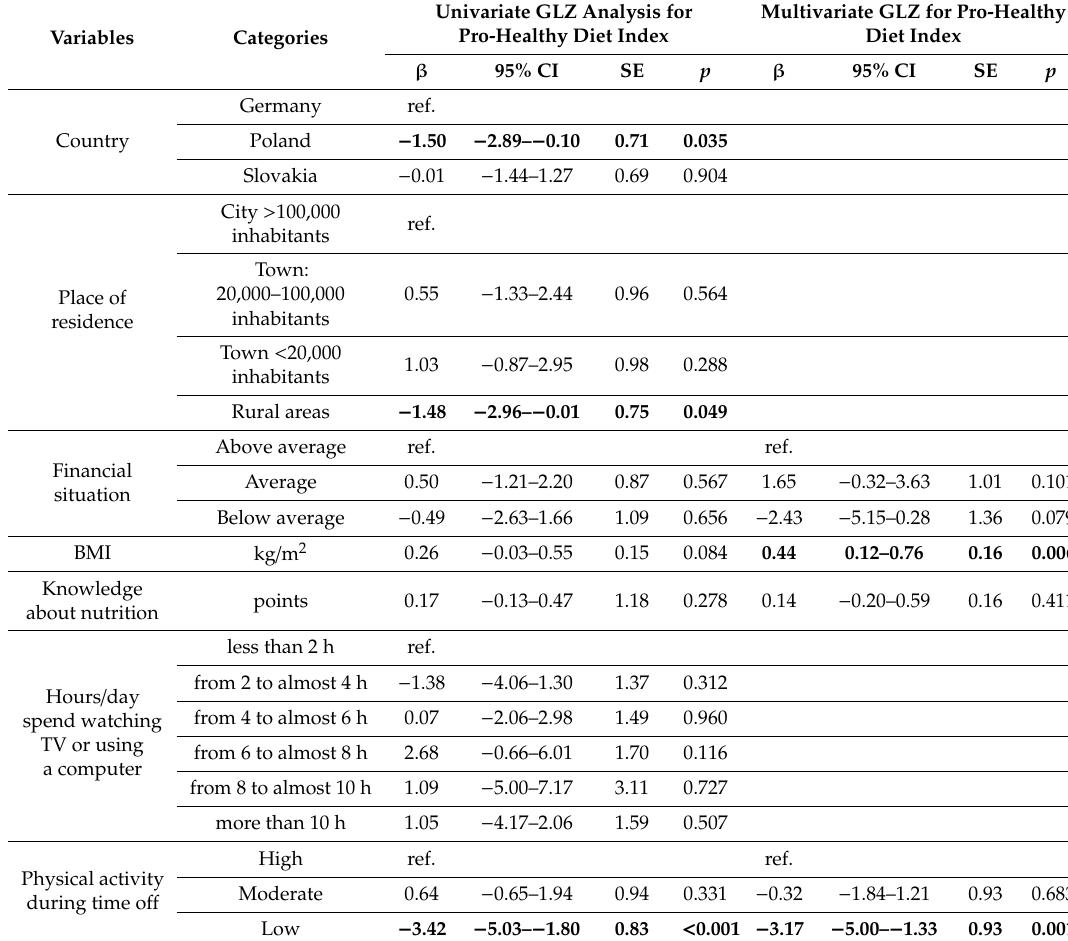
Table 5. Univariate and multivariate generalized linear regression analysis for Pro-Healthy Diet Index.